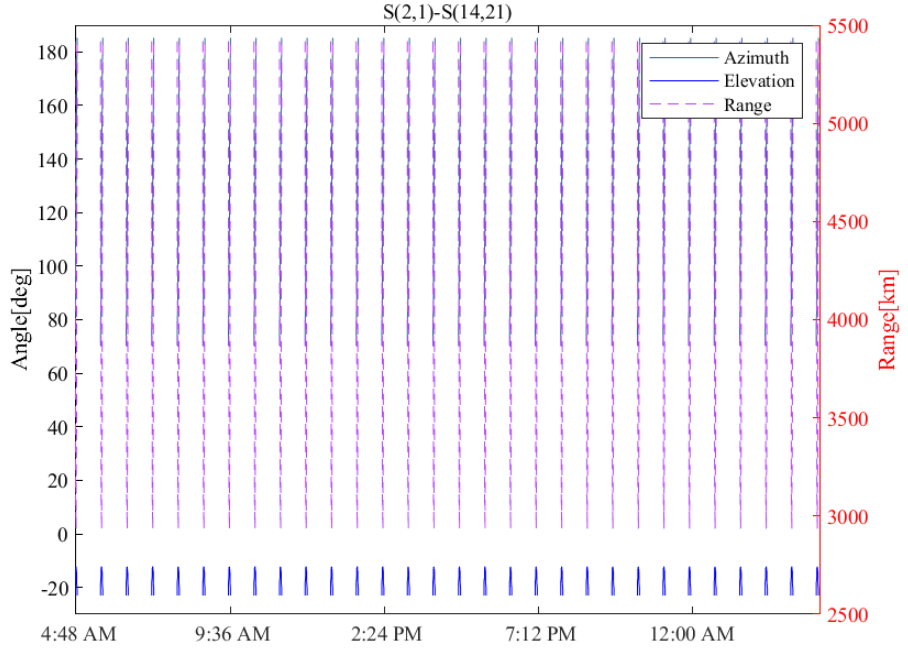
Figure 16. Crossing orbital link AER characterization diagram.